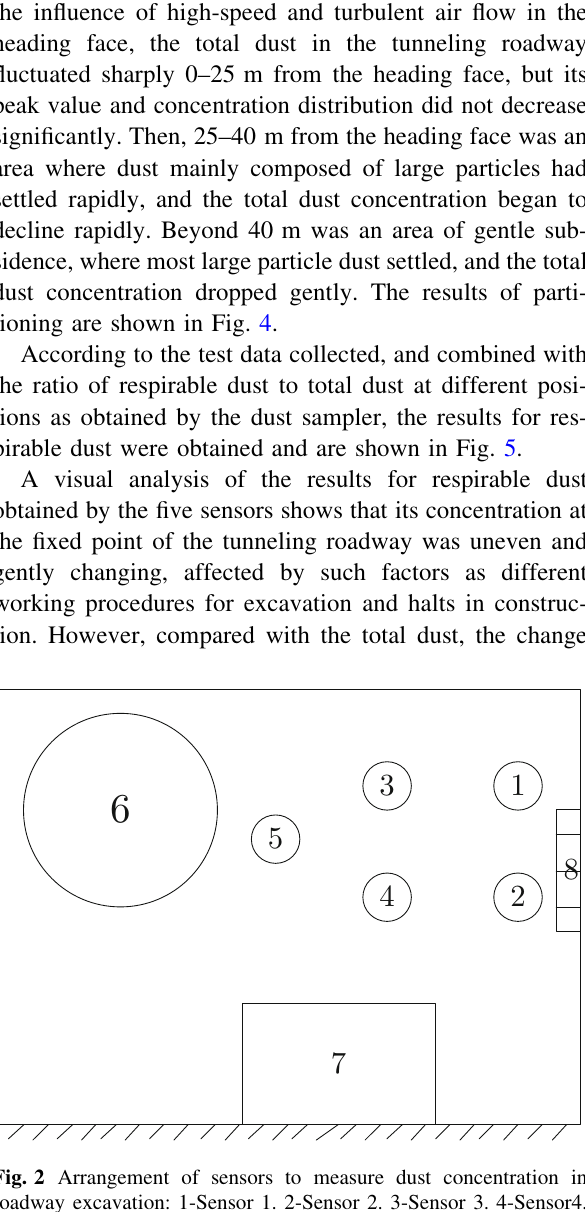
Fig. 1 Connection structure of the sensor